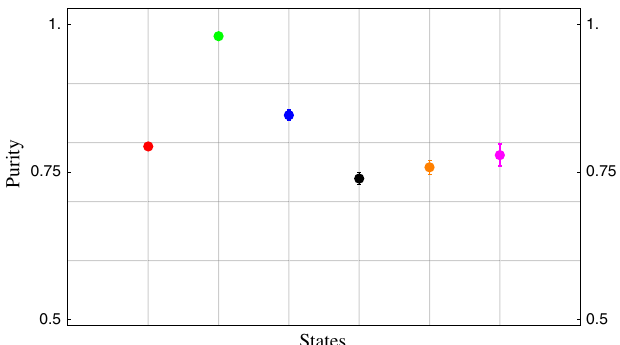
FIG. 7. Purity of the four-qubit states. Representatives of the L (red), L (green), L 0 (blue), L (black), L a 2 b 2 abc 2 a 2 0 3 ⊕ ¯1 ab 3 3 ⊕ ¯1 0 3 ⊕ ¯1 (orange), and G (magenta) families. The error bars are abcd also